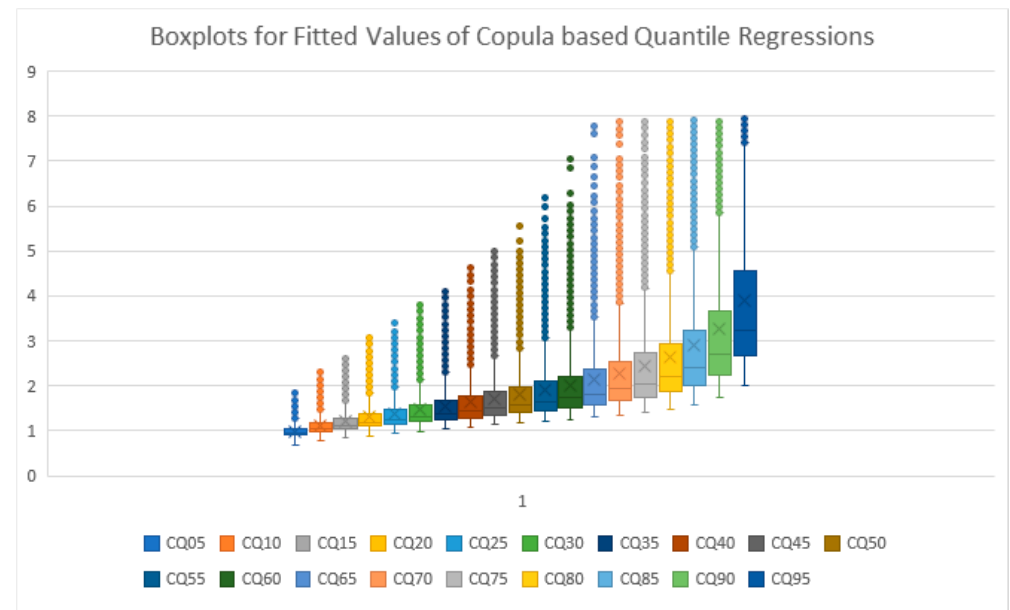
Figure 4. Plots for Fitted values of Nonparametric Copula based Quantile Regressions.